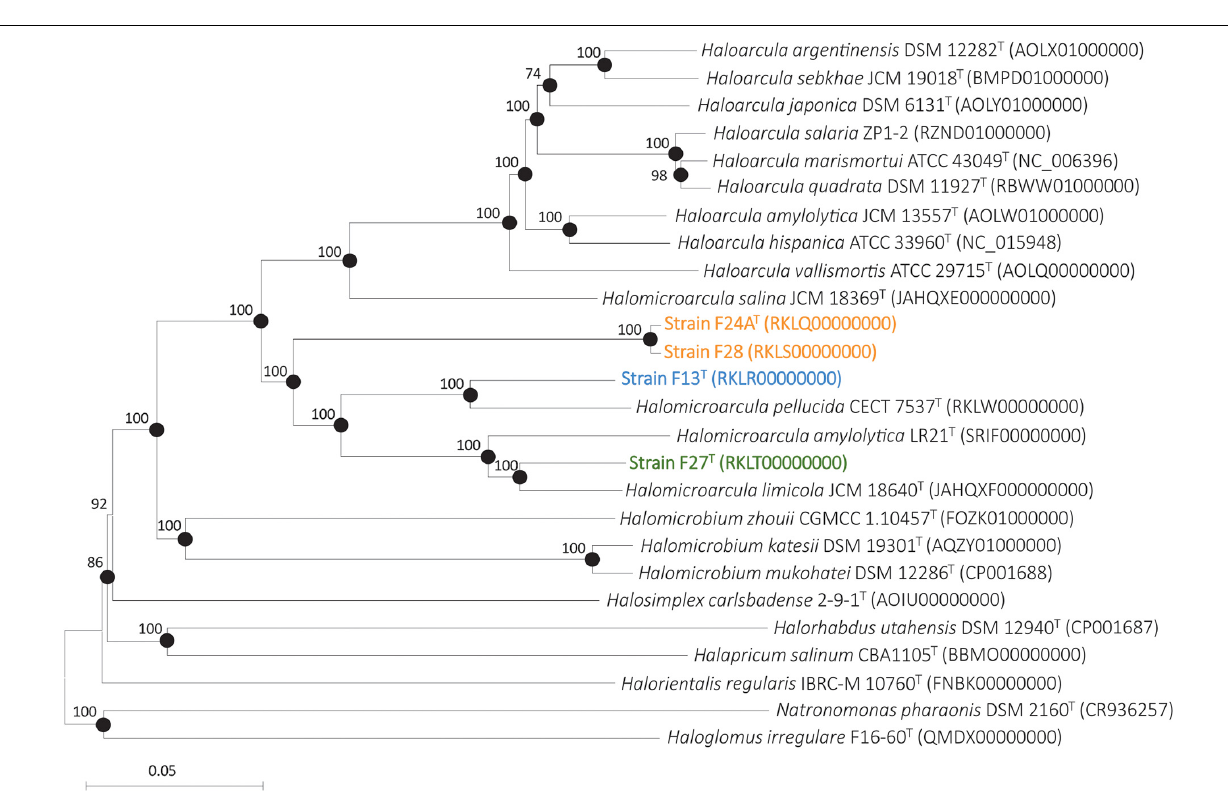
accepted for the delineation at the genus level. It is noticeable that the AAI percentages for the new isolates and current species species of the genus Haloarcula ) are 71.0%, 71.0%, 71.5%,